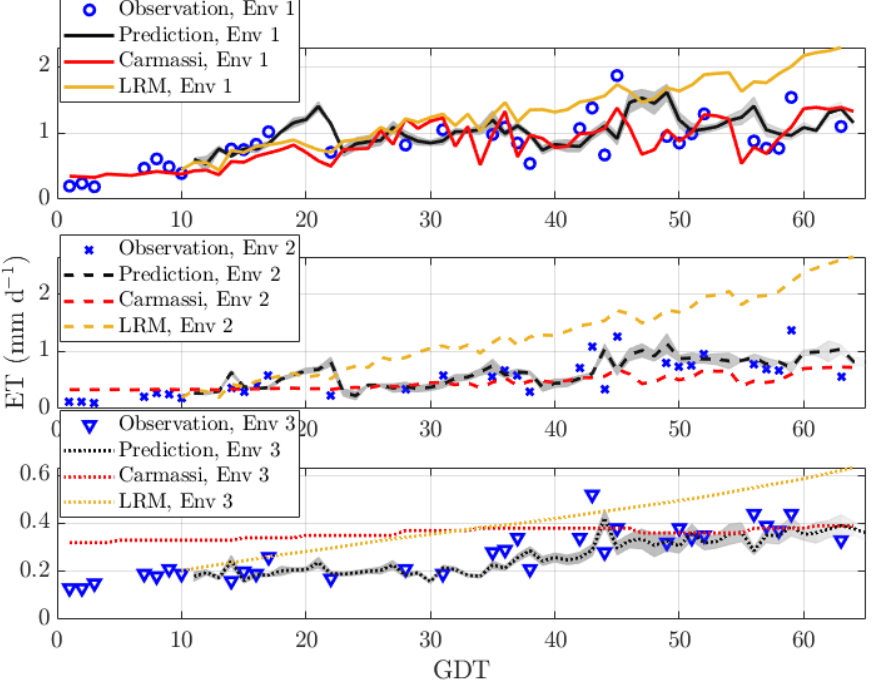
Figure 4. Prediction of the ET for MicroTom with sparse data in three environments: Env 1 (warm and bright), Env 2 (shaded and emergency heating), and Env 3 (indoor and artificial illumination).